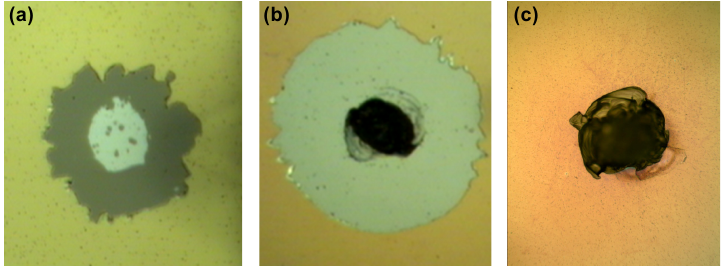
Figure 8. Optical microscope images highlighting the damage morphology of a damage pit from the ( a ) RFS //Nb 2 O 5 /SiO 2 ; ( b ) RFS //ZrO 2 /SiO 2 ; and ( c ) DCS //ZrO 2 /SiN coatings. The inner damage zone is circa 30 μ m in diameter in each case.